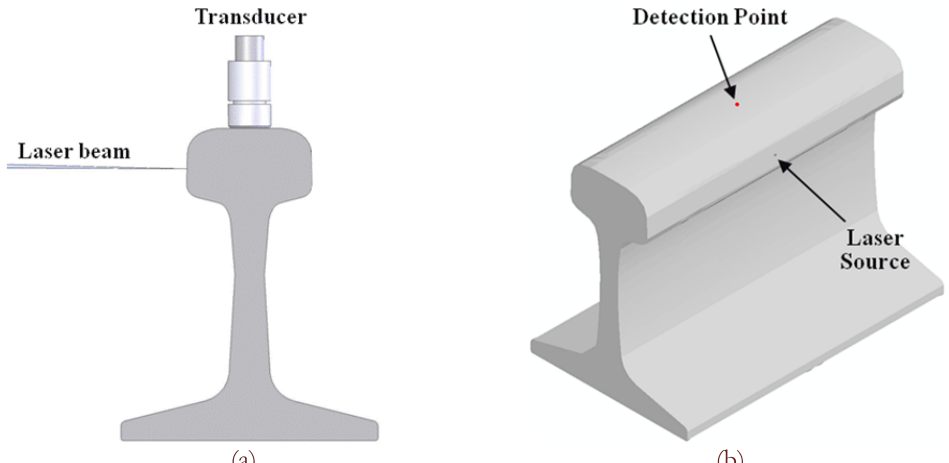
Figura 6: a) Schema del setup sperimentale e b) modello agli elementi finiti della rotaia senza difetti.